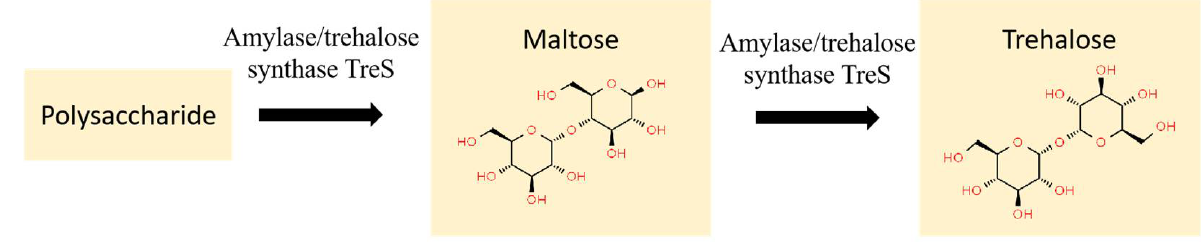
Figure 2. The trehalose synthesis pathway of treS in H. kocurii 2020YC7.